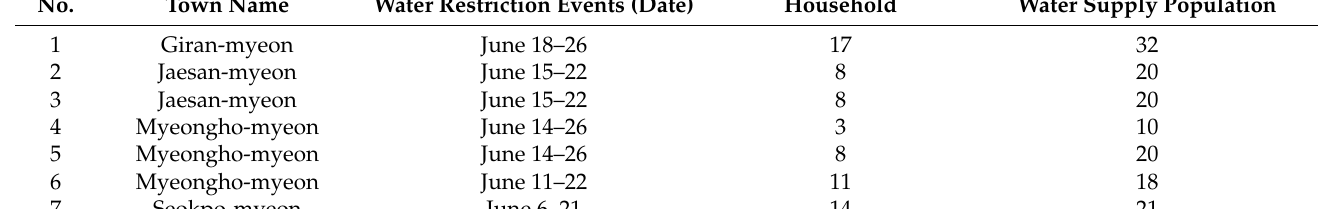
Table 6. Status of damages from water restriction at Nakdong River Basin covering the study area (2015). No.